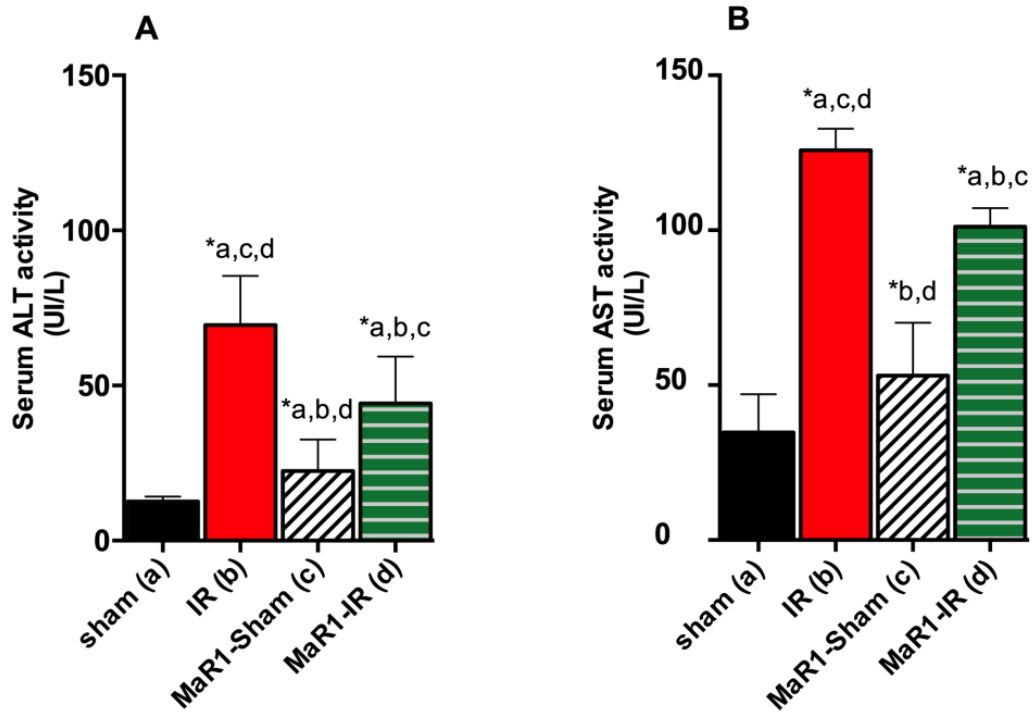
Figure 1. Effect of maresin-1 (MaR1) on serum ( A ) alanine aminotransferase (ALT) and ( B ) aspartate aminotransferase (AST) levels after liver ischemia (1 h)-reperfusion (3 h) (IR). Values correspond to means ± SEM of 9 animals per experimental group. Significance was assessed by one-way analysis of variance (ANOVA) and the Tukey’s post-test. Asterisk indicates p < 0.05, and the letters identify the experiments that are compared and present this statistical difference.